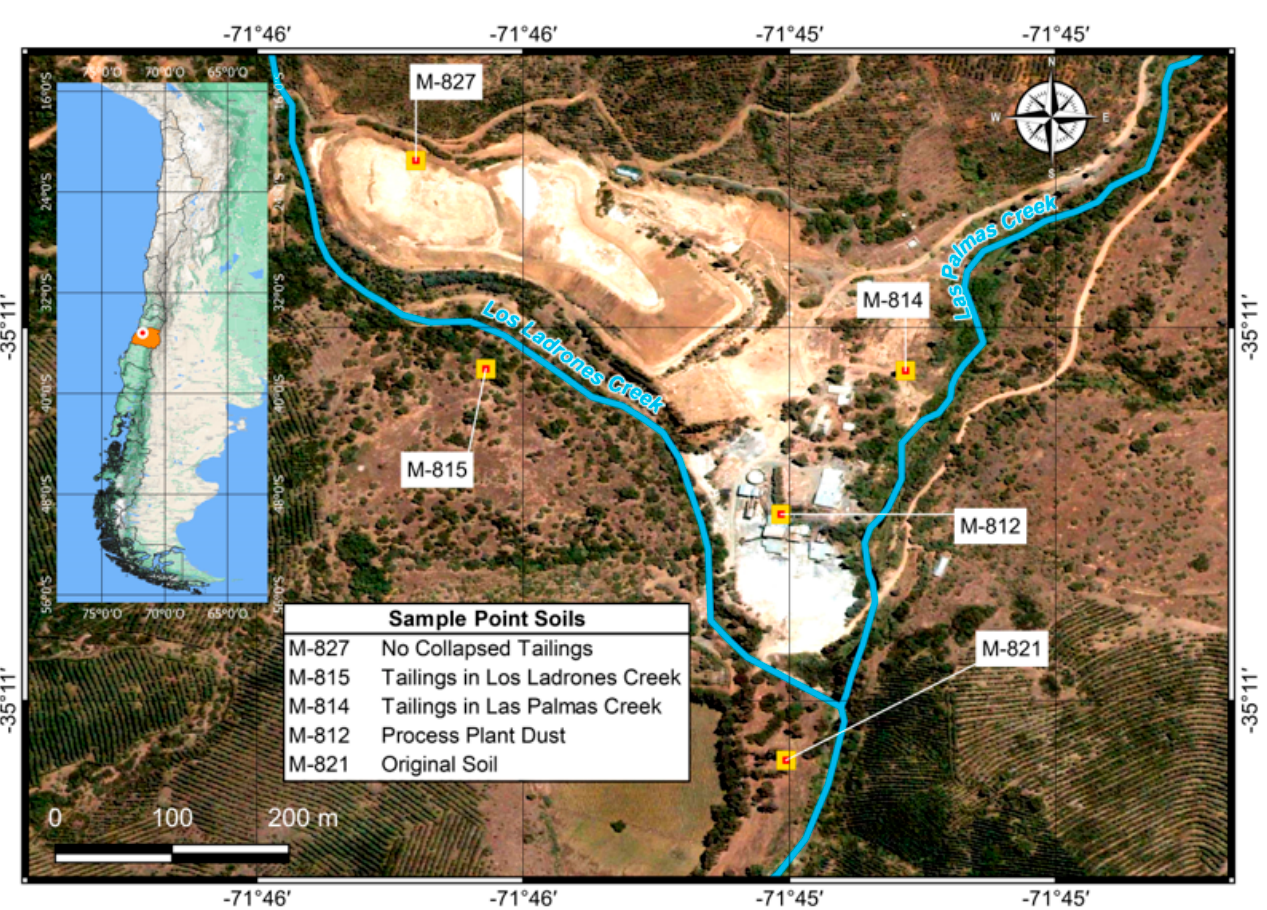
Figure 17. Area affected by mining tailings spill in Las Palmas creek, soil sampling (Modified from [63]).